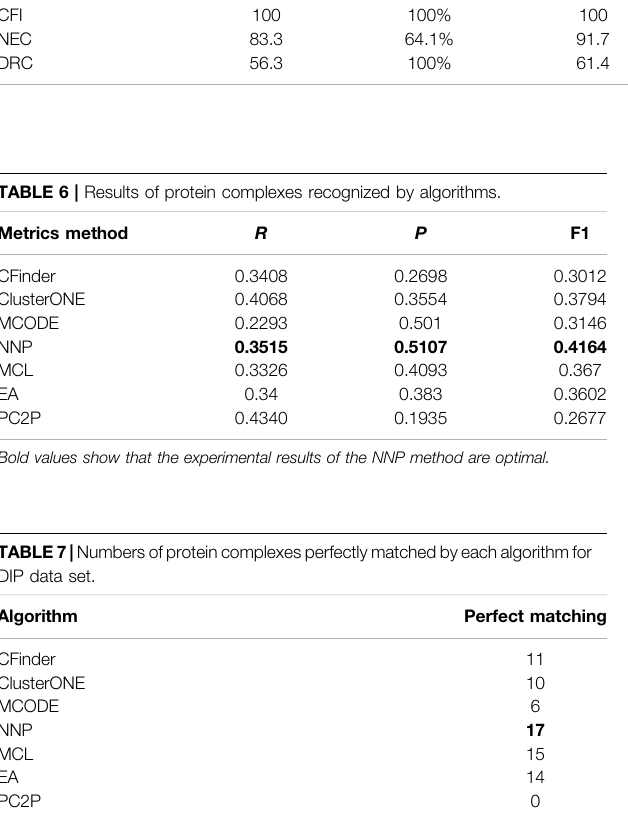
TABLE 5 | Three complexes identi fi ed by methods were analyzed from the DIP. Algorithm Protein complex